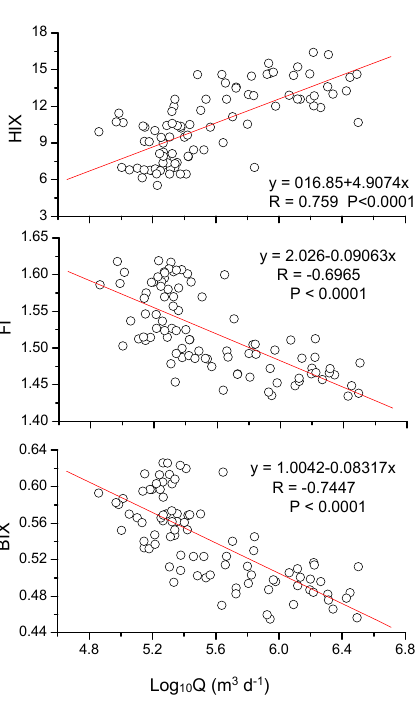
Figure 6. Relationships between discharge ( Q ) and the three in- dices during the 2012–2014 sampling period.